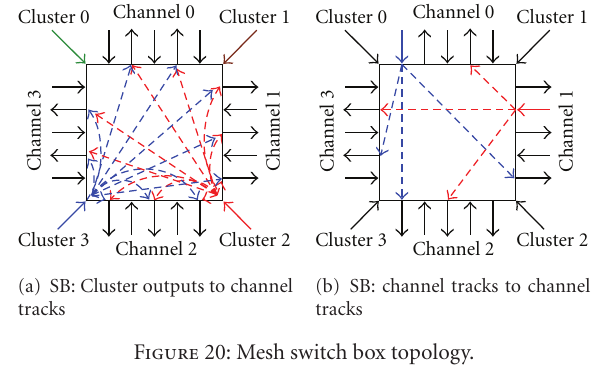
Figure 20: Mesh switch box topology.